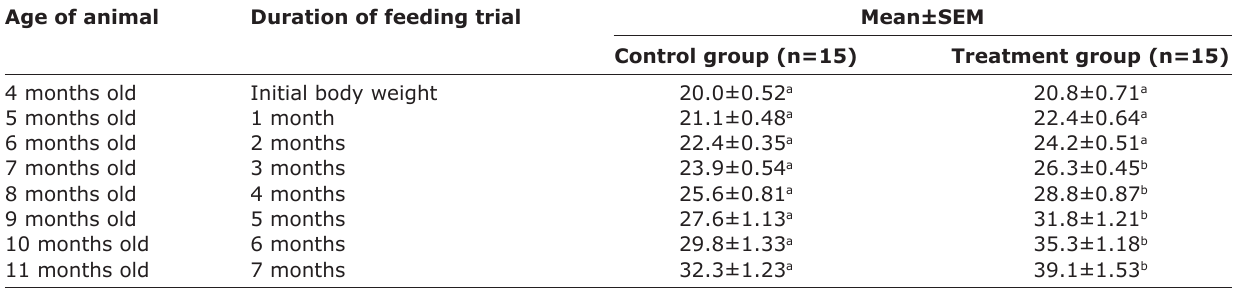
Table-4: The measurement of body weight in control and treatment groups throughout feeding trial. Age of animal